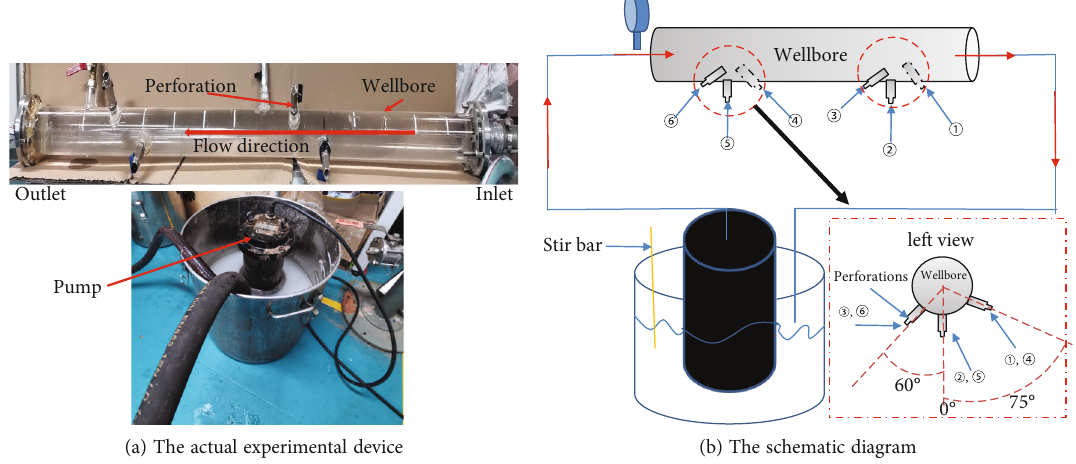
Figure 1: Settlement and di ff erentiation simulation device for particle in wellbore. Table 1: Parameters of multicluster perforating experiment device for horizontal